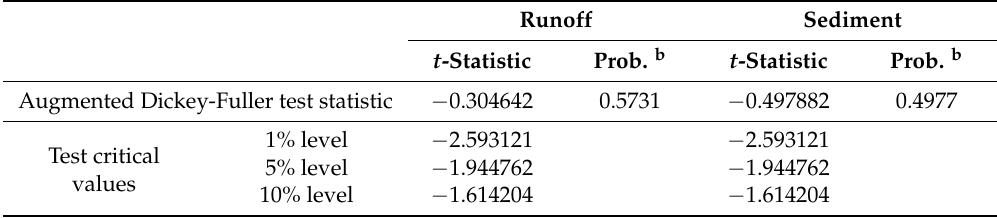
Table 2. ADF test results of residuals removing the seasonal effect a .